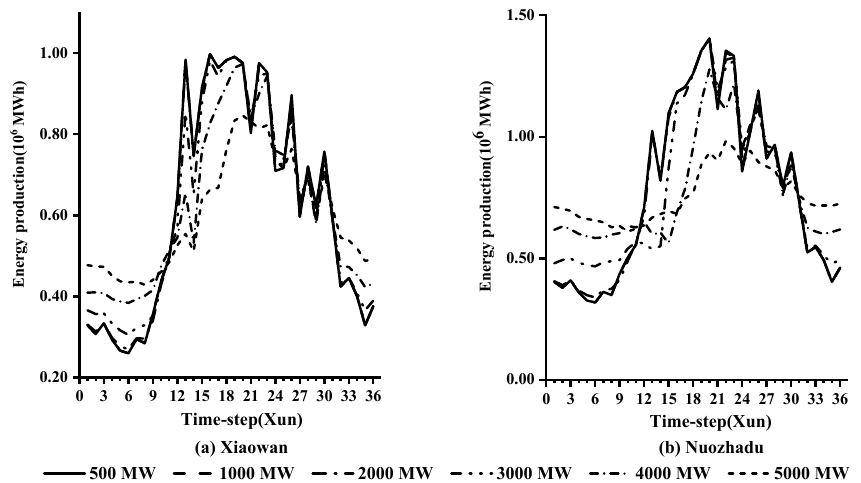
Table 3. The reliability of the power yield for the cascade.